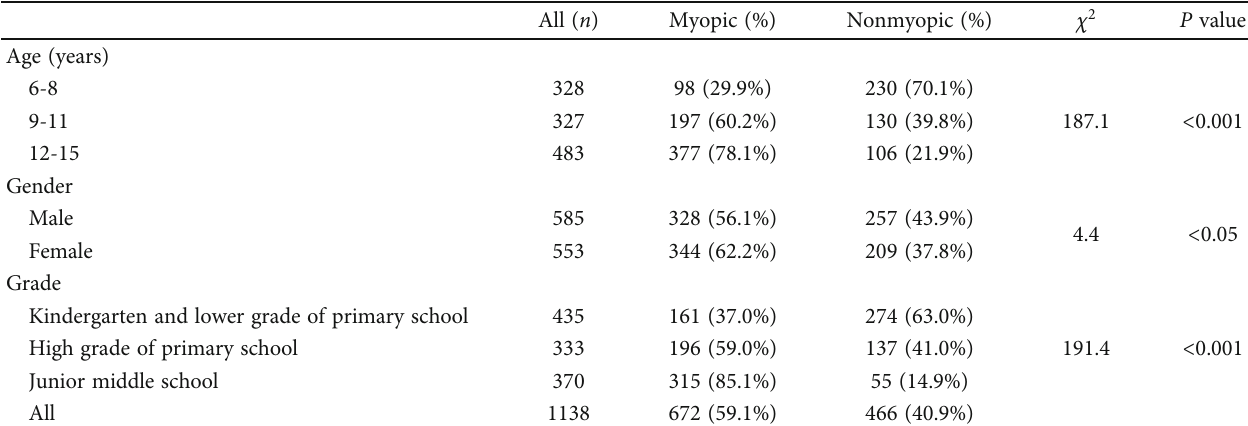
Table 2: Prevalence of myopia by age, gender, and grade.